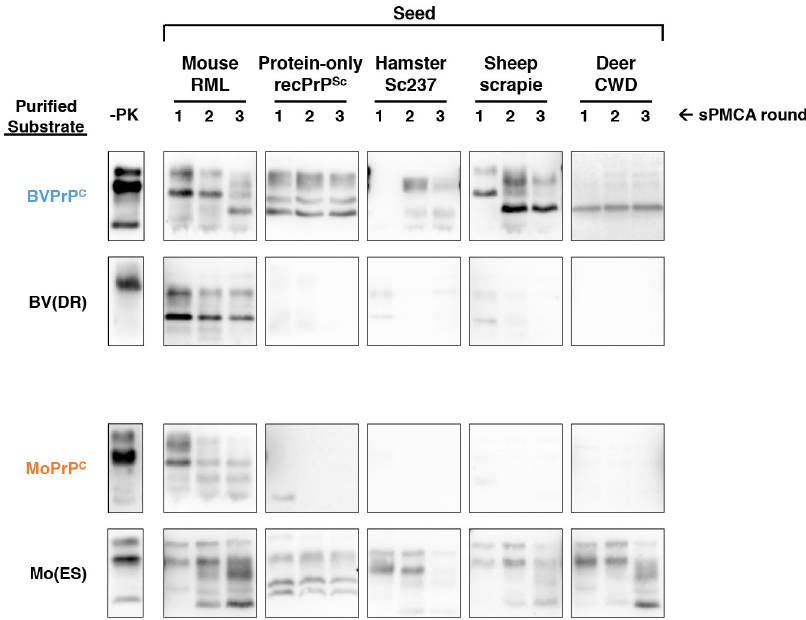
Fig 7. Determining the effect of specific BV and Mo amino acids on the species barrier. Western blots of experiments showing three-round reconstituted sPMCA reactions using partially purified PrP C substrates supplemented with PrP 0/0 BH and initially seeded on day 0 with various seeds, as indicated. Day 0 samples are a seeded reaction not subject to sonication. -PK = samples not subjected to proteinase K digestion; all other samples were proteolyzed.